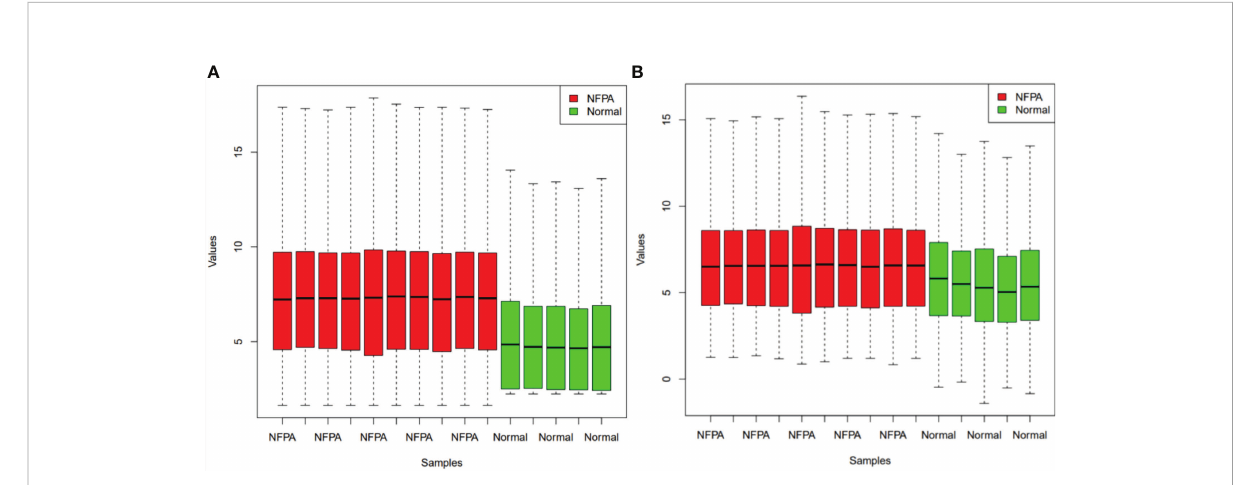
FIGURE 1 Boxplots for the data before (A) and after (B) batch effect removal. Red boxes indicate NFPA samples and green boxes show healthy